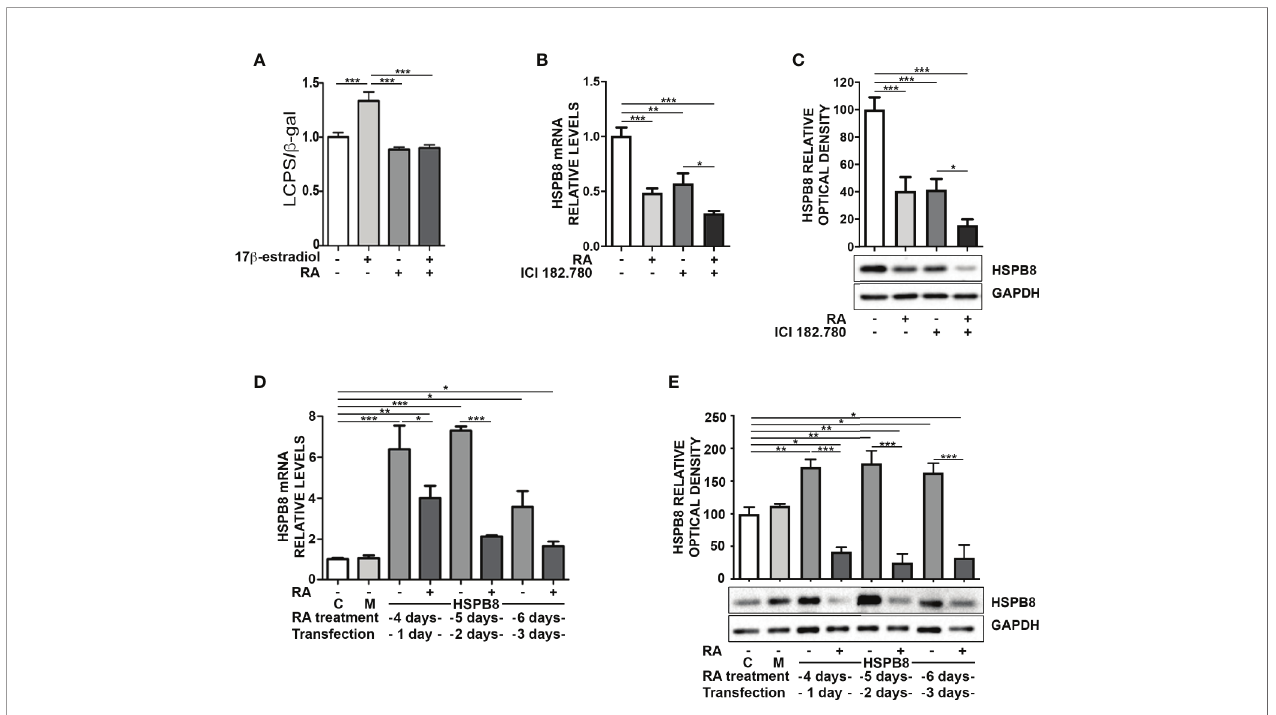
FIGURE 2 | Promoter independent modulation of HSPB8 is induced by RA in MCF-7 cells. (A) Transcriptional activity assay of MCF-7 cells treated with 1 m M RA and/or 10nM 17 b -estradiol transfected with hPromB8-LUC and pCMV- b -gal. Luciferase activity is expressed as luminescence counts per second (LCPS) normalized on b -galactosidase ( b -gal) expression. HSPB8 mRNA (B) and protein levels (C) measured by RT-qPCR analysis and western blot analysis in MCF-7 cells treated for 2 days with 1 m M RA and/or 100nM ICI 182.780. (D) HSPB8 mRNA levels measured by RT-qPCR analysis in MCF-7 cells. (E) HSPB8 protein levels measured by western blot analysis in MCF-7 cells. For D, E untreated cells (C) , mock-transfected cells (M) or cells treated up to 6 days with 1 m M RA and transfected at day 3 with the plasmid overexpressing wild-type HSPB8. Analyses were performed at 1, 2 and 3 days after transfection. *p < 0.05, **p < 0.01 and ***p < 0.005 in all charts. Graph bars represent the mean of three independent